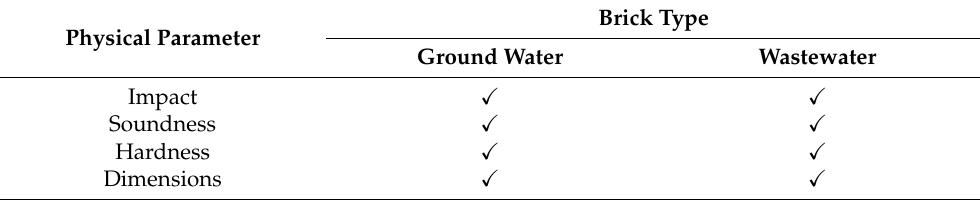
Brick Type Ground Water Wastewater